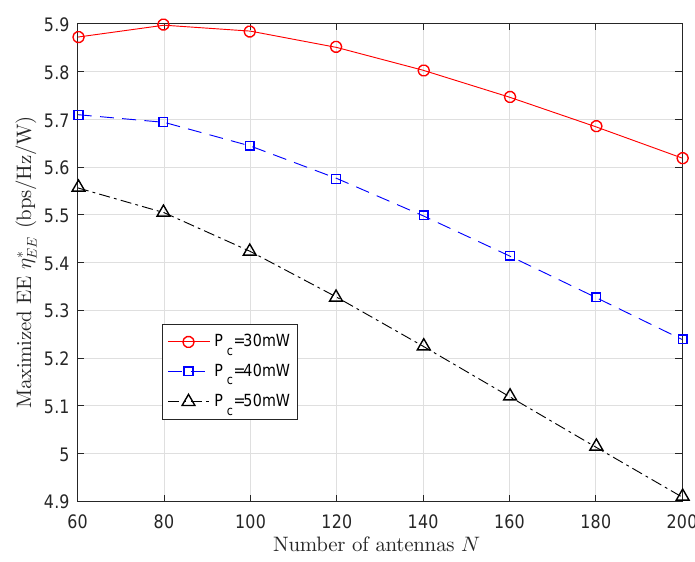
Figure 6. The maximized energy efficieny versus the number of